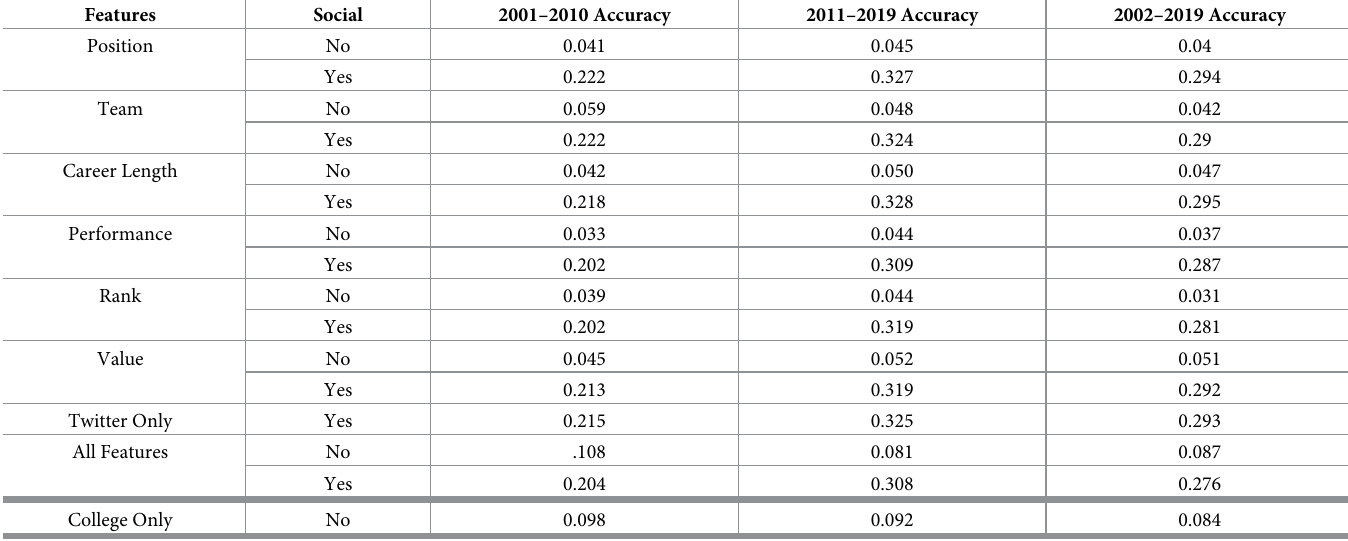
Table 11. Basketball inference and prediction accuracy: (Top) The inference accuracy using Random Forest for team transition in NBA during the time periods 2002–2010, 2011–2019, and 2002–2019 is shown . (Bottom) The prediction accuracy using the players’ college data to predict team transitions during 2001–2019 is